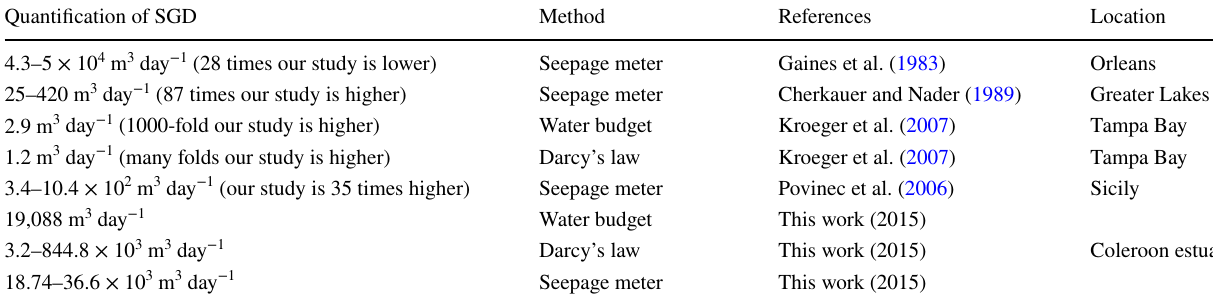
Table 5 Comparison of this study SGD fluxes with global averages Quantification of